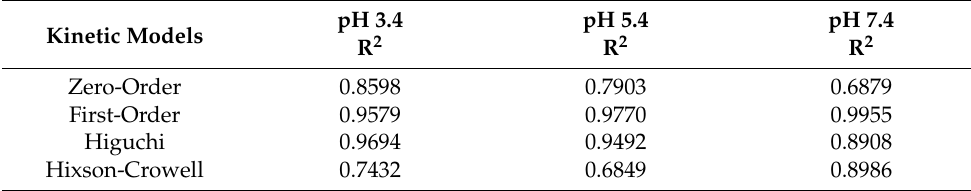
Table 2. Kinetic study of the in vitro release data of KAE-GEL. Kinetic